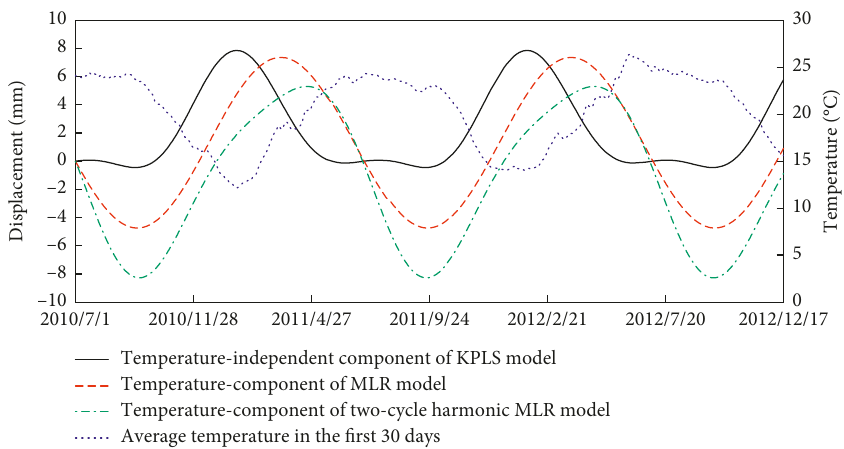
Figure 11: Comparison of the temperature components of models for radial displacement.